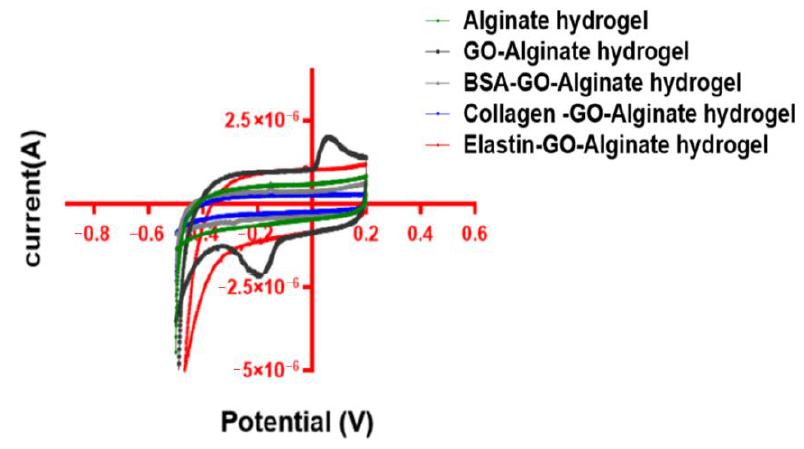
Figure 8. Voltammograms from protein-coated GO alginate and alginate hydrogels.